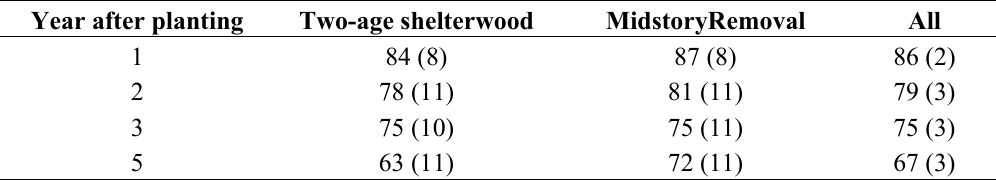
Table 2. Least-squares means for percent survival within silvicultural treatments and raw means across treatments with associated standard errors in parenthesis for each year after planting American chestnuts. Year after